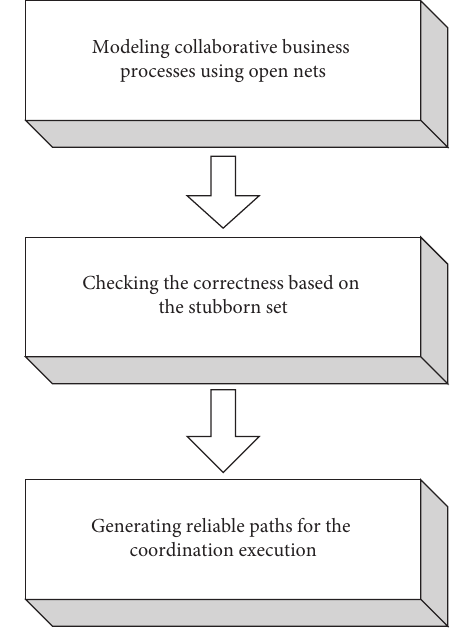
Figure 1: Overview of our